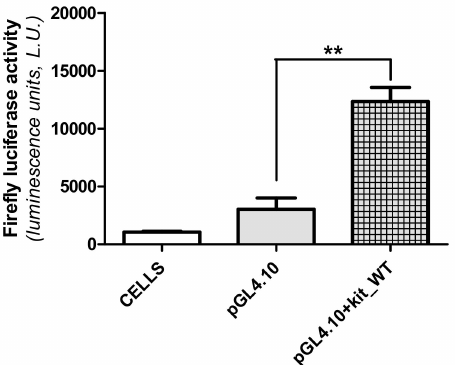
Figure 4. Transcriptional activity of the WT KIT proximal promoter. The promoter sequence (kit_WT: − 65/ − 210 from ATG or − 7/ − 152 from the TSS) was cloned into a pGL4.10 luciferase vector and transfected into MCF-7 cells. Firefly luciferase activity was assessed using ONE-GloTM Luciferase Assay System. pGL4.10+kit_WT transcriptional activity was compared to the one obtained for the empty pGL4.10 vector. Data (mean ± SEM) are representative of three independent